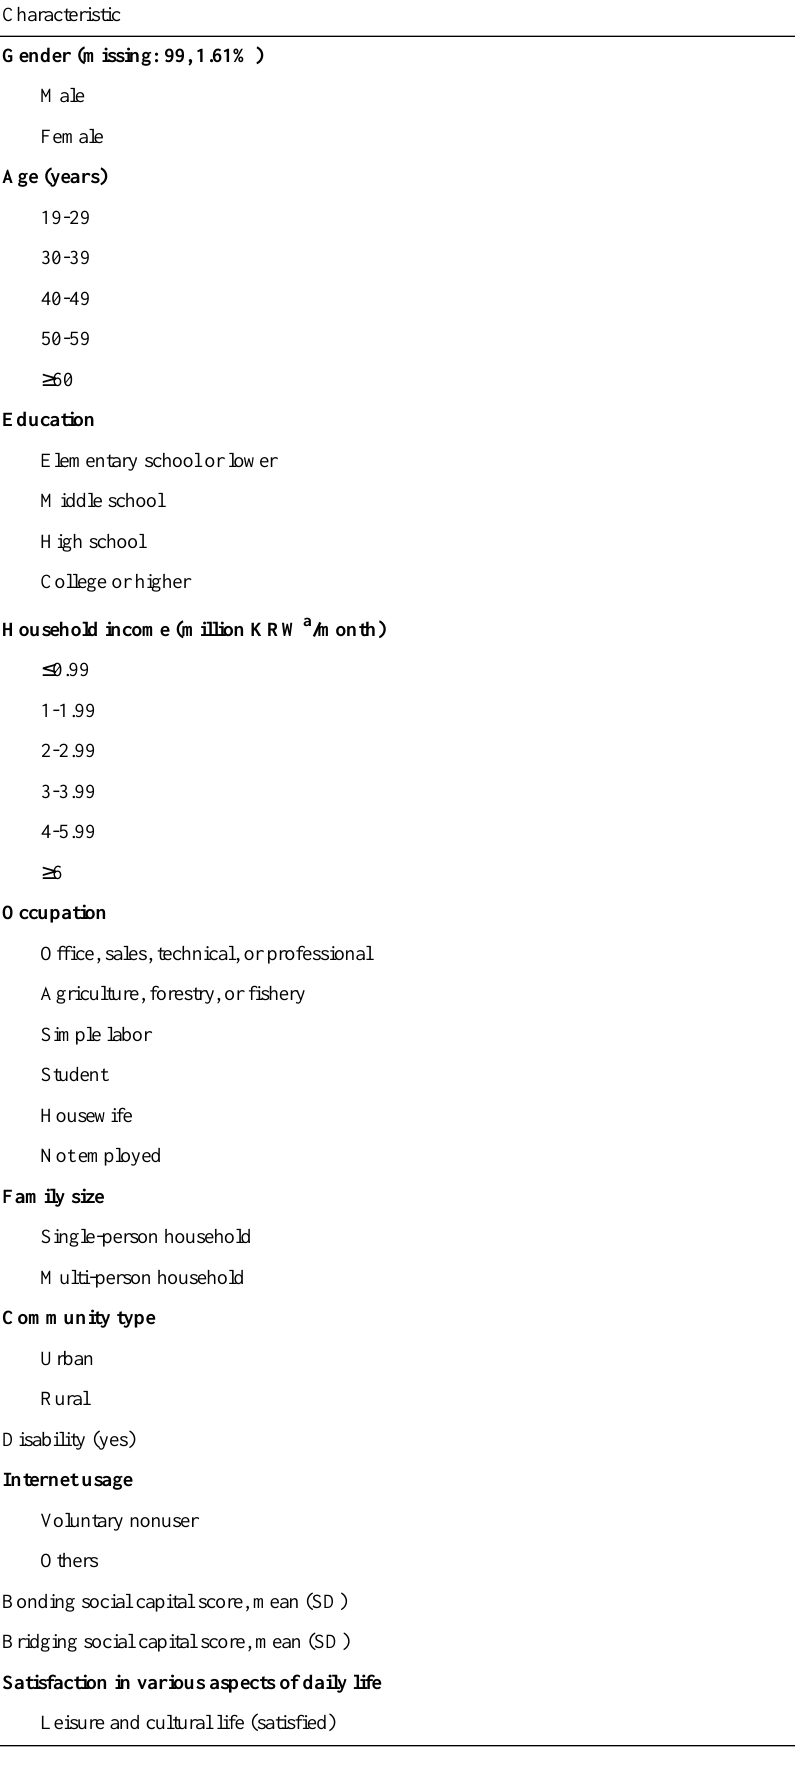
Table 1. Characteristics of the sample (N=6150).